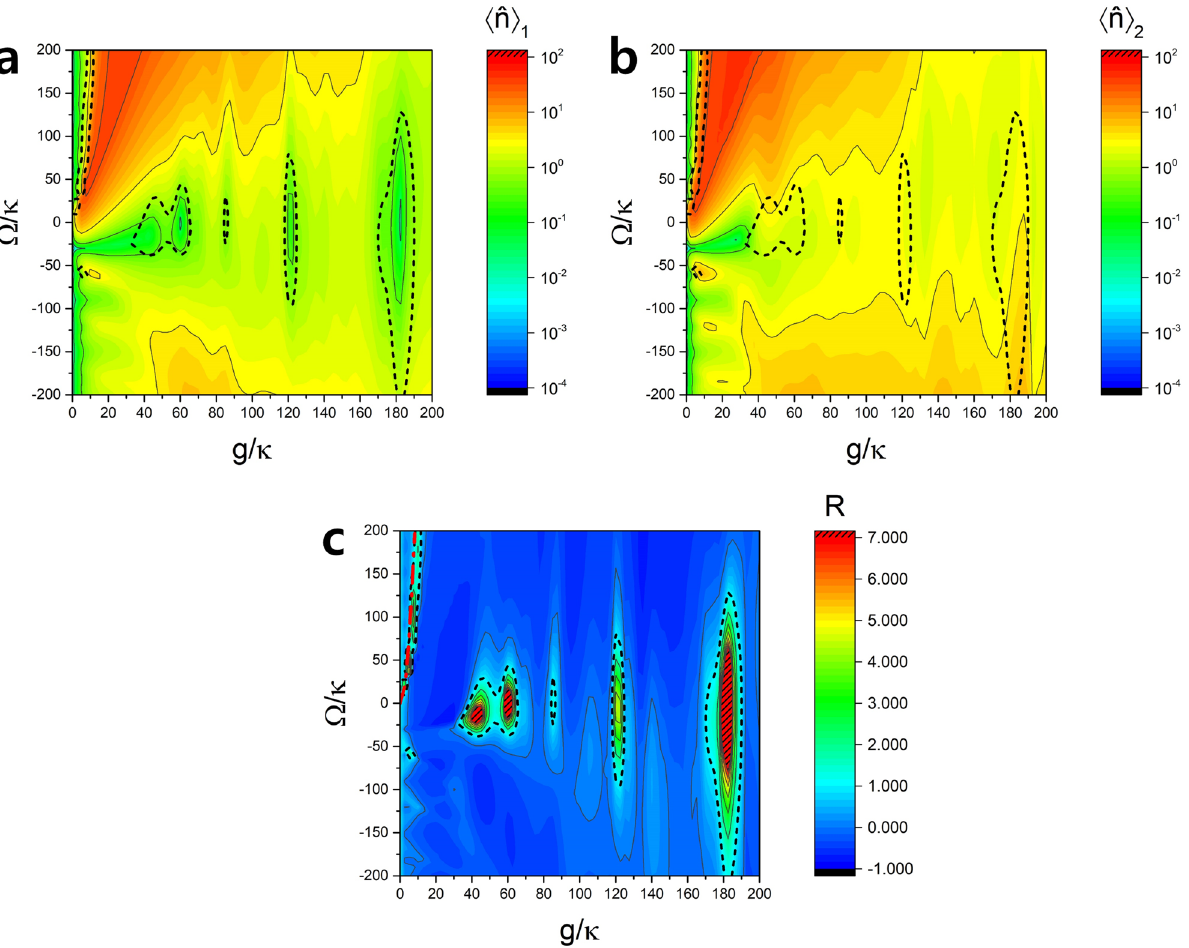
Figure 3. Dependance of hyperradiance on g/ κ and �/κ . ( a ) Average number of photons in the cavity of one- atom case. ( b ) The same for two-atom case. ( c ) Radiance witness R . The hatched red regions indicates R > 7.0 . 0 ) with the interaction time τ 0.052 /κ , the cavity decay time 1 /κ 1.93 We consider a resonance case( (cid:31) = = = µ s and φ π/ 2 . The red dash-dot curve for small g /κ is the plot of Eq. (8). Hyperradiance region is inside the = black dashed